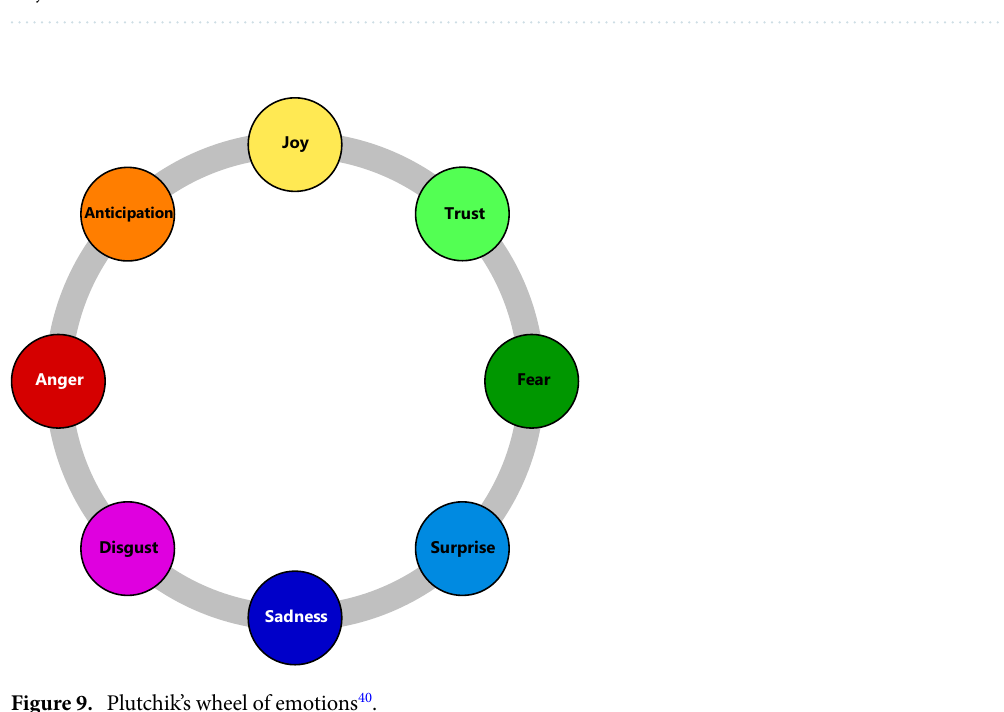
Table 1. Examples of rumors posted on Twitter. Fact-checking labels from http:// polit ifact. com. Fact-checking labels from the other websites show high pairwise agreement, with true and false labels being completely disjunct 17 .